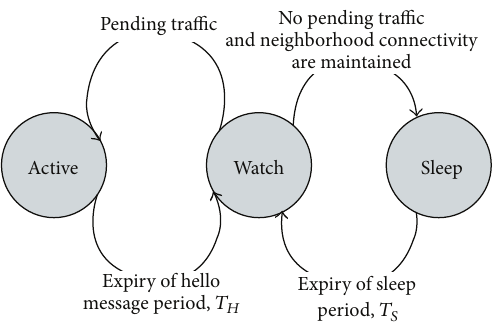
Figure 3: State transition in LBTC.